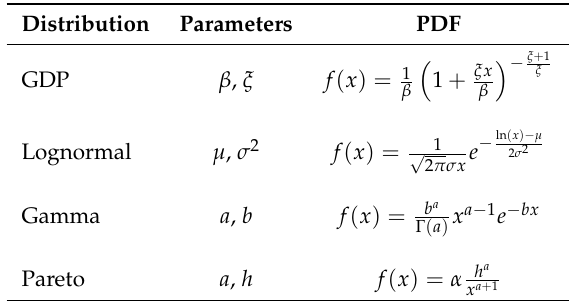
Table 3. Some common distribution for losses